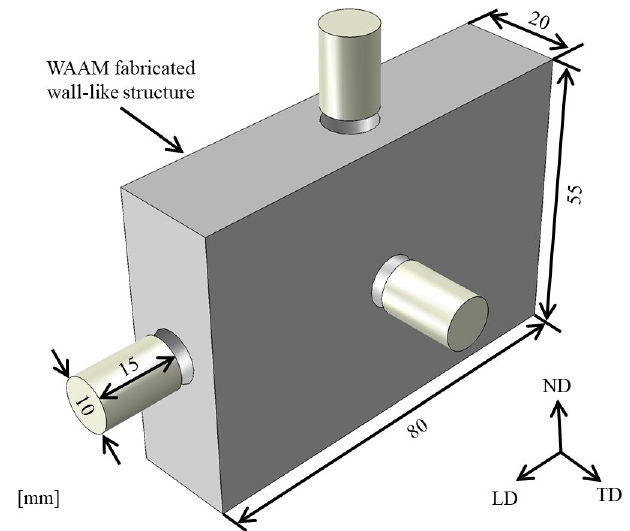
Figure 1. Schematic of the direction of compression test coupons, extracted from the WAAM- fabricated blocks of Ti-6Al-4V, AA2319, and S355JR steel. Directions of [001], [010], and [100] are fixed parallel to the transverse (TD), normal (ND) and longitudinal (LD) directions, respectively, for EBSD